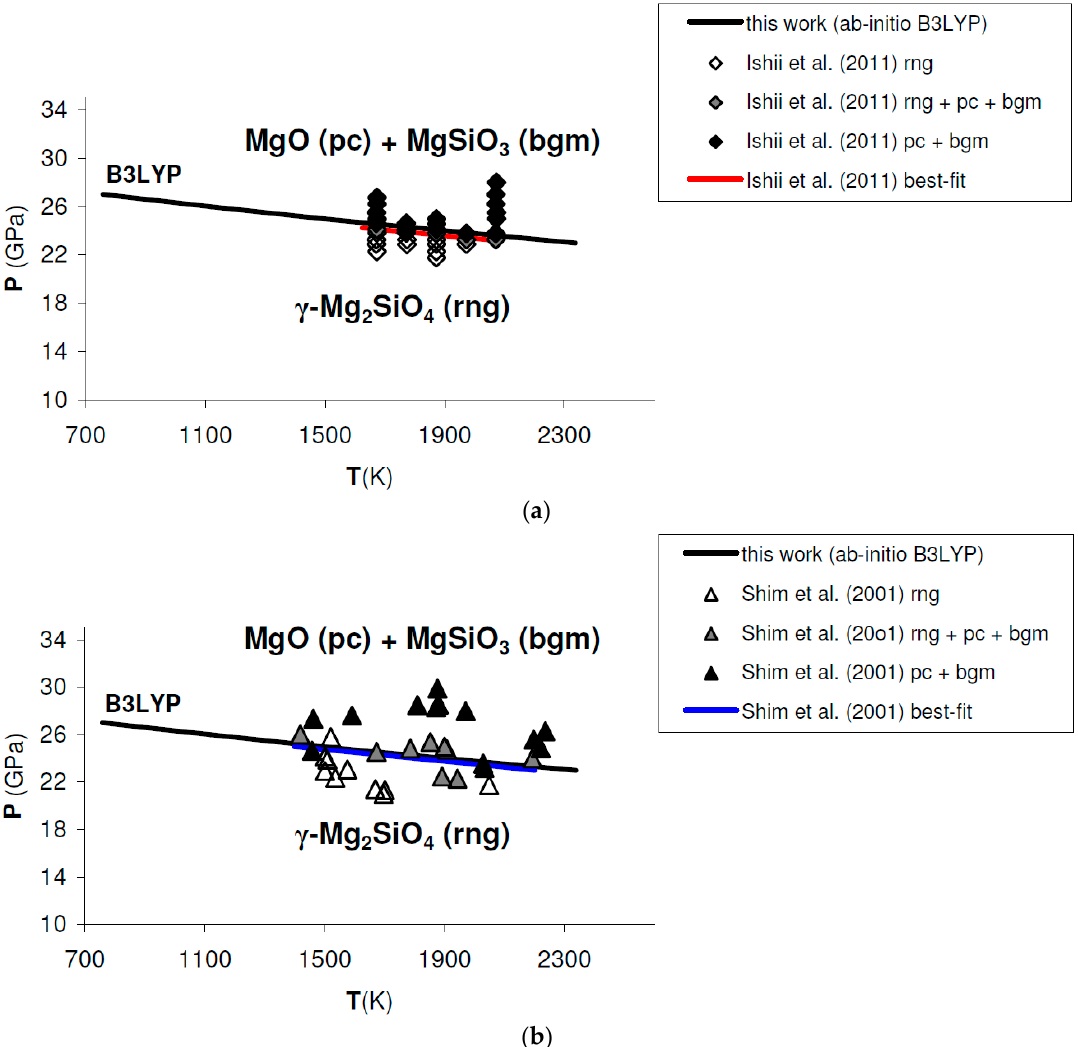
Figure A2. Ab initio B3LYP phase boundary of post-spinel transformation (in bold) as compared to: ( a ) results obtained by multi-anvil experiments (diamonds) [132]; ( b ) results obtained by laser-heated diamond-anvil cell experiments (triangles) [128]. Best-fits of experimental results are also indicated. Abbreviations for minerals as in Figure 11.